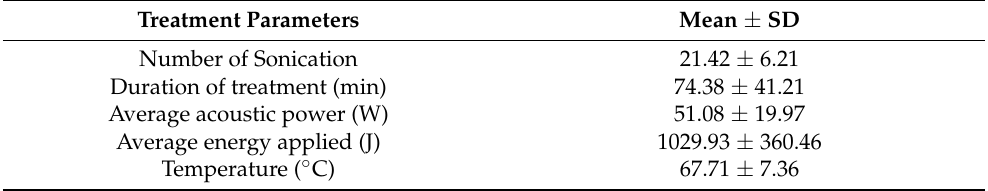
Table 3. Summary of treatment parameters for